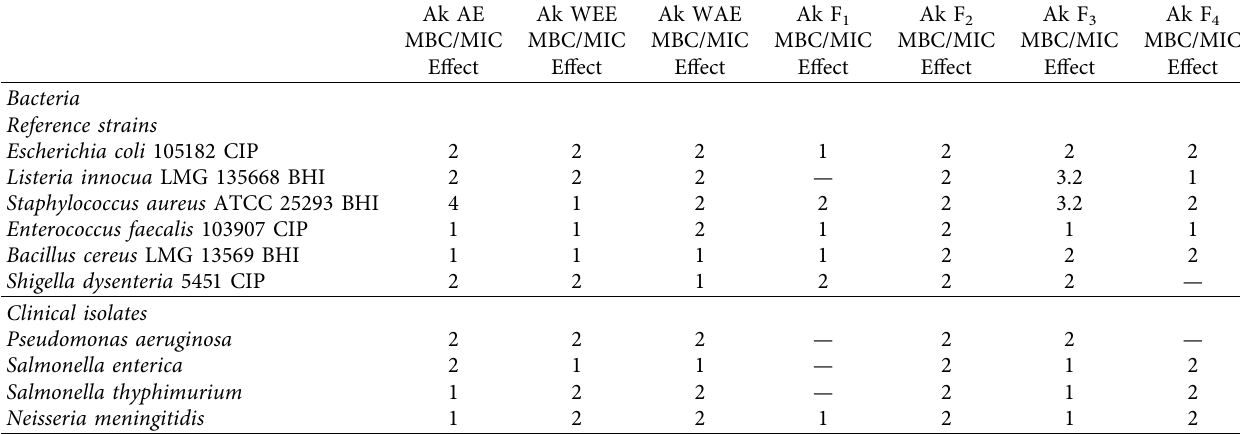
Table 4: Antimicrobial efects of plants extracts from Antrocaryon klaineanum .